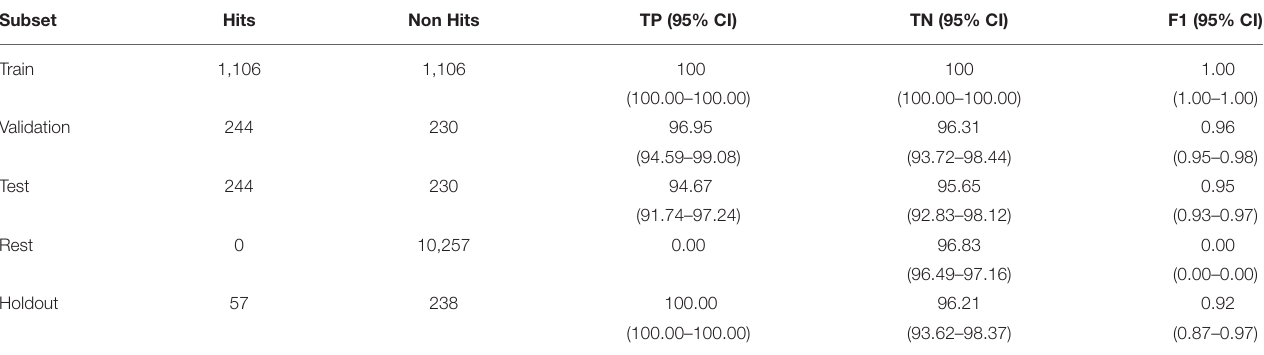
TABLE 3 | Train, validation, test, rest, and holdout set number of impacts included and performance of classifier for true positives (TP) and true negatives (TN) as a percentage of correctly labeled data and F1 score (F1) with 95% confidence intervals (95%